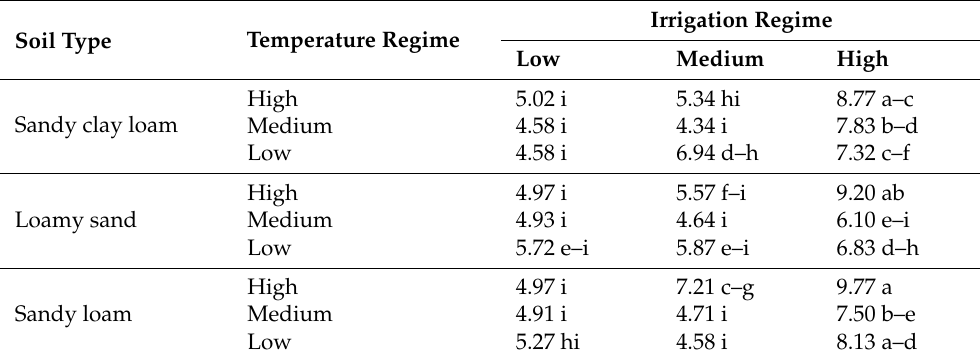
Table 3. Interactive effect of soil type, air temperature and irrigation regimes on number of